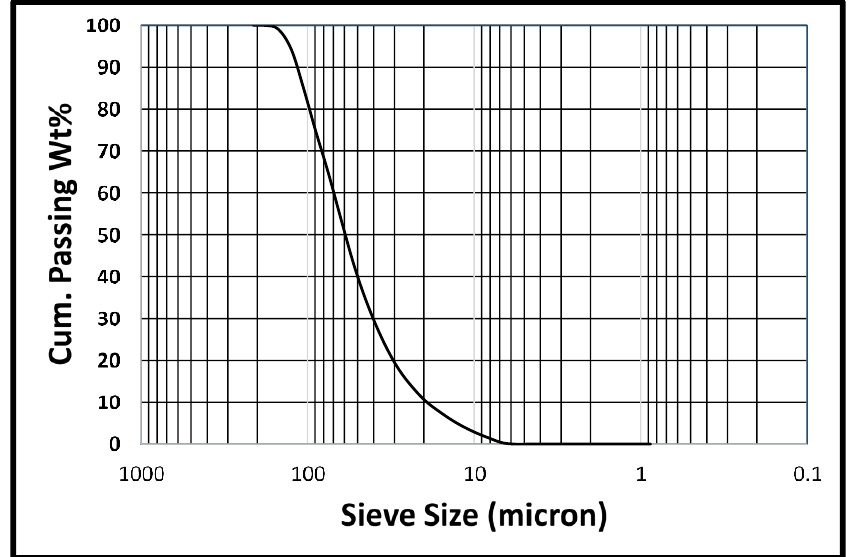
Figure 3. Particle size distribution of the flotation feed.